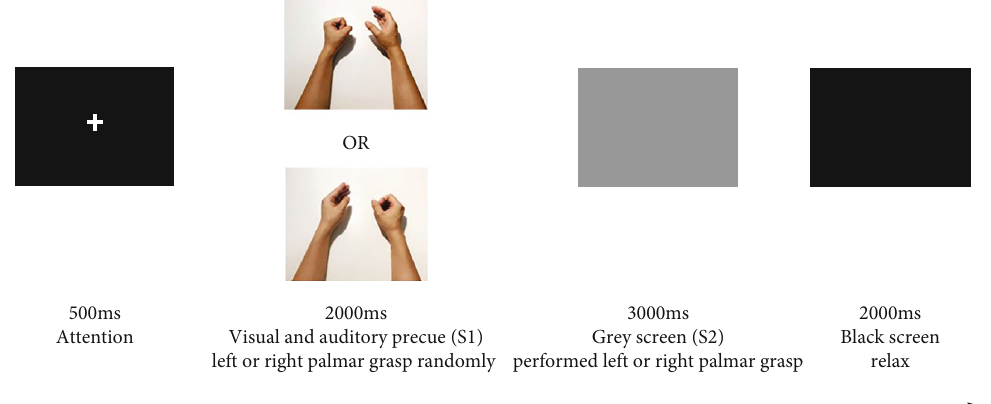
Figure 2: Diagrams of the experimental setup.